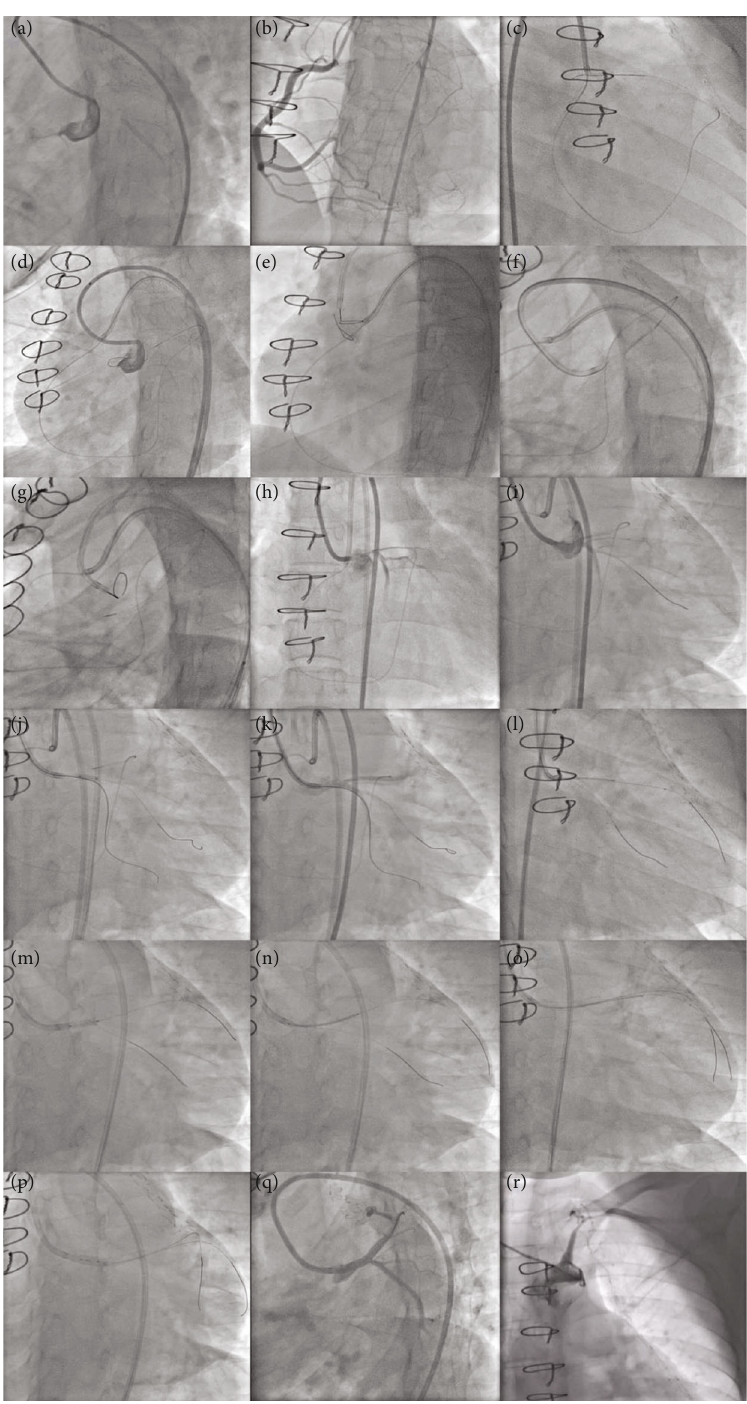
Figure 1: Angiographic images showing initial PCI for LMCA CTO. Left anterior oblique (LAO) caudal view showed LMCA total occlusion (a), and antero posterior (AP) cranial view showed normal RCA giving multiple collaterals to both LAD and LCX (b). LMCA lesion was crossed retrogradely using Fielder FC and caravel through septal collateral from RCA (c), and externalization into 7F EBU 3.5 antegrade guiding catheter was attempted by conventional method (d). After multiple failed attempts to enter antegrade guiding catheter, snaring was attempted using Amplatz goose neck snare (e). After multiple failed attempts of externalization and antegrade wiring (f – h), fi nally, SION black guidewire crossed LMCA lesion antegradely (i). Then, Fielder XTR guidewire was parked in LCX, and LMCA lesion was dilated with 2 : 5 × 8 mm NC balloon (j, k). After IVUS analysis (l), LMCA lesion was again dilated with 3 × 10 mm cutting balloon (m). Then, LMCA-LAD stenting was done with 3 : 5 × 26 mm ZES (n). After stenting, IVUS analysis showed underexpansion (o), and hence, postdilatation was done using 4 × 8 mm NC balloon (p). Final angiogram showed well expanded stent with good distal fl ow in LAD and LCX (q). Left subclavian artery angiogram showed stenosis at the proximal segment and atretic LIMA